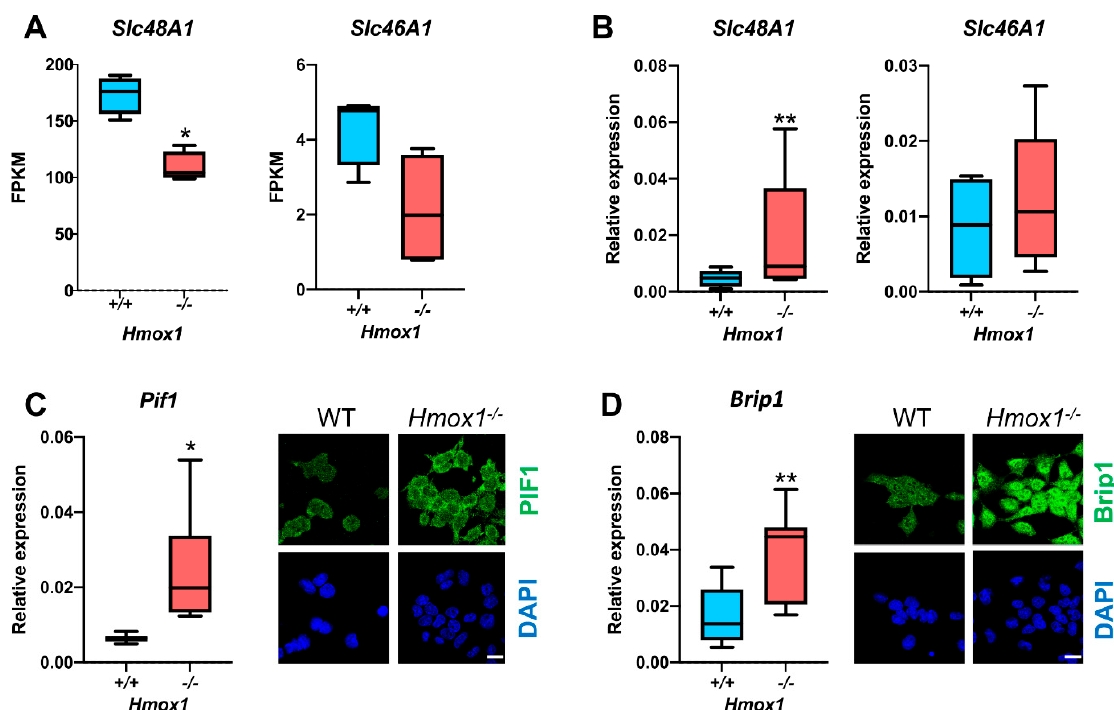
Figure 2. Expression of Slc48A1 and Slc46A1 in mouse Hmox1 +/+ or Hmox1 − / − HSCs ( A ) and mouse Hmox1 +/+ or Hmox1 − / − iPSCs ( B ). Expression of Pif1 ( C ) and Brip1 ( D ) at the mRNA (graphs) and protein (photos) levels in iPSCs. Gene expression was assessed with RNA-seq in FACS-sorted bone marrow HSCs [42] or with real-time RT-PCR in cultured iPSCs. The box-and-whiskers graphs show the median, 25th and 75th percentile (box) minimum, and maximum values (whiskers) of the FPKM (fragments per kilobase million) or relative expression in comparison to house-keeping genes (geometric mean for HPRT, B2M, and β -actin), n = 4, * p < 0.05, ** p < 0.01, Mann–Whitney test (HSCs) or Wilcoxon test (iPSCs). Representative pictures showing Pif1 and Brip1 immunostaining. Nuclei are labeled with DAPI. Scale bars: 20 μ m.